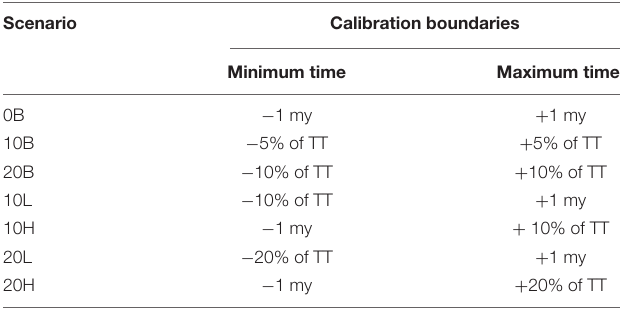
TABLE 1 | Scenarios of varying uncertainty around the true time (TT) for primary calibration